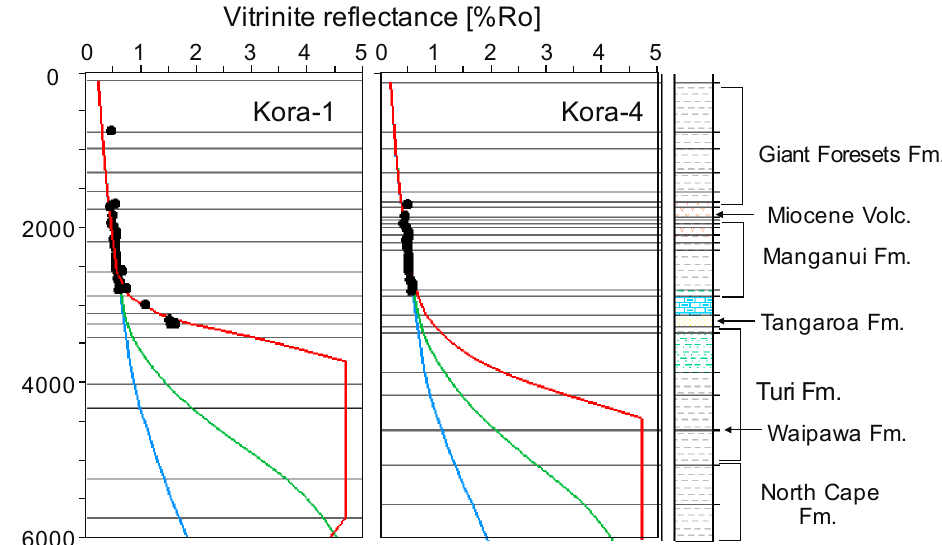
Figure 11. Vitrinite reflectance curves for three scenarios for Kora-1 and Kora-4 wells. Blue curve represents the base case scenario without intrusion; Red curve - magmatic intrusion in sediments at 11 Ma; green curve—scenario with magmatic intrusion in basement (200 mW / m 2 ) at 11 Ma.